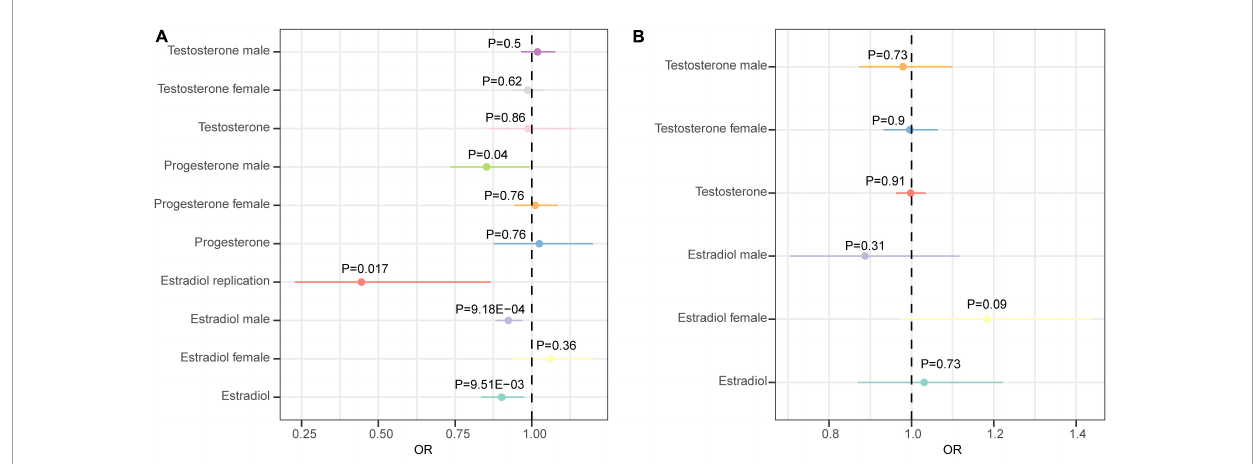
FIGURE1 Forest plot showing results from the Mendelian randomization analysis. (A) Results from the Mendelian randomization (MR) analysis to evaluate the causal role of hormone traits in epilepsy using the inverse variance weighted method. (B) Results from the MR analysis to evaluate the causal role of epilepsy in hormone traits using the inverse variance weighted method. Estimates are per 1 standard deviation (SD) increase in the trait.